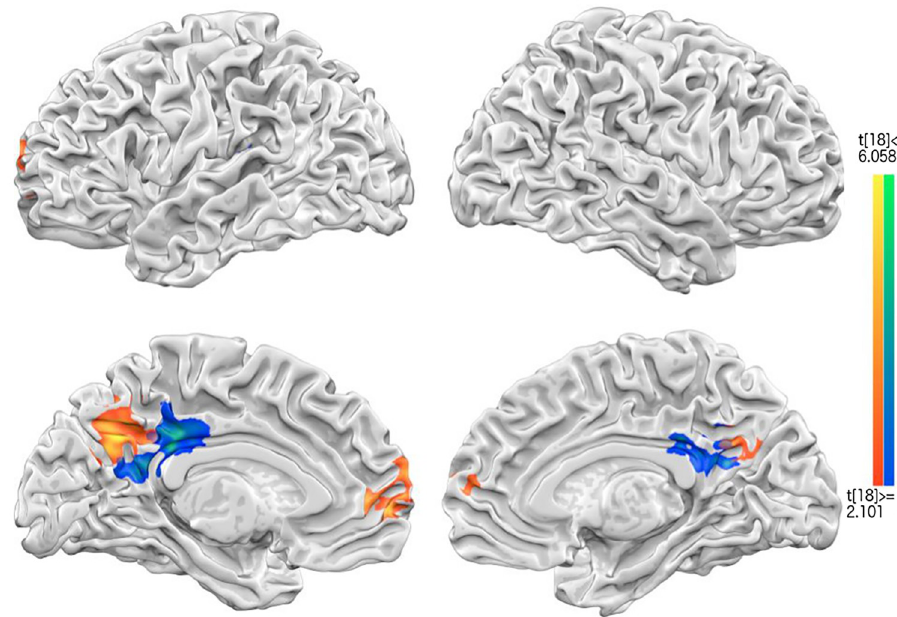
Fig 3. The results of GLM contrast analysis. Interpersonal > Neutral conditions, shown in orange color; and Intrapersonal > Neutral conditions, shown in blue. The medial prefrontal cortex (MPFC) and Precuneus (Prec) were significantly activated for Interpersonal > neutral condition, whereas the posterior cingulate cortex (PCC) were engaged for Intrapersonal > Neutral condition. As can be seen, there was some overlap between the two contrast